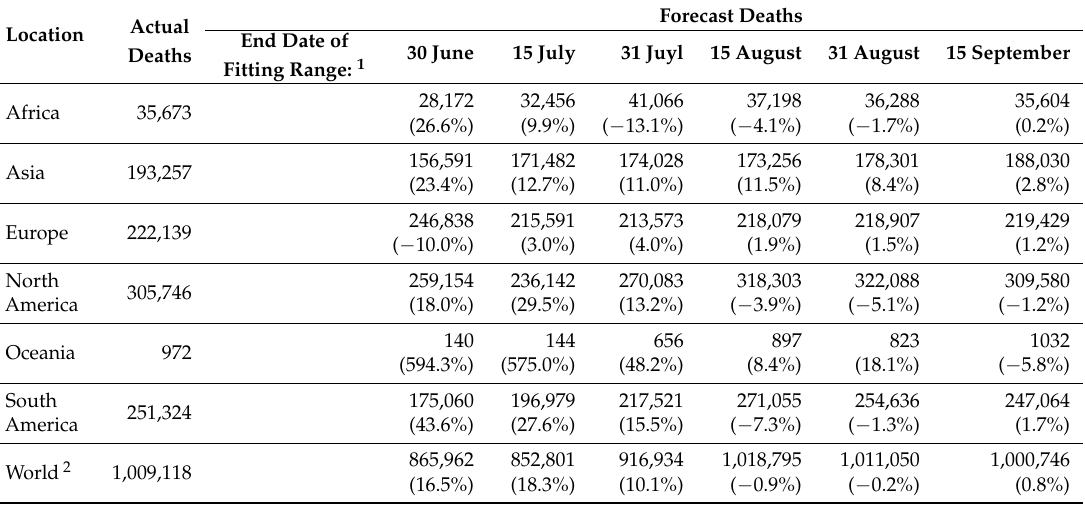
Table 2. Actual and forecast deaths on 30 September